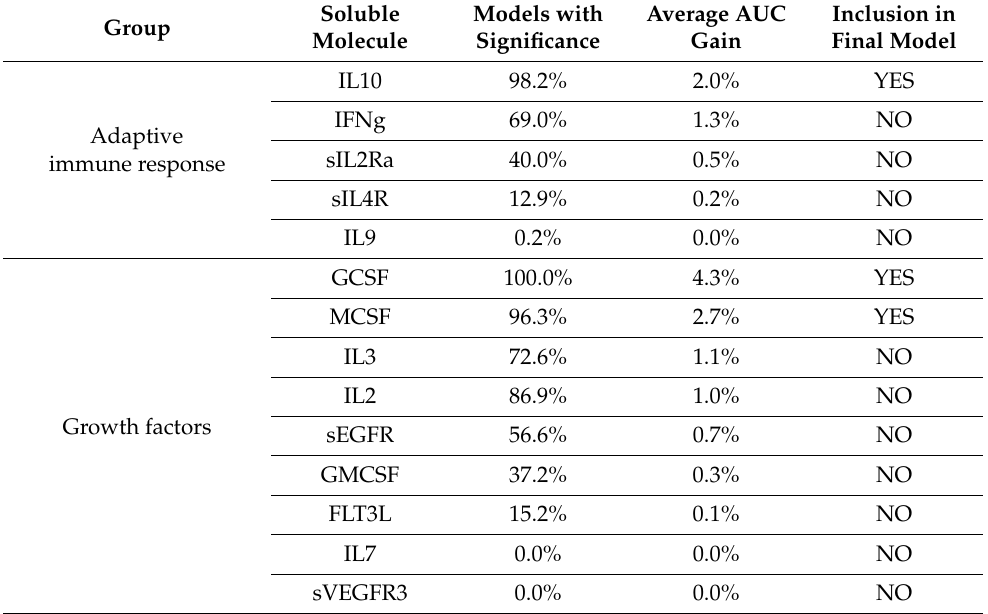
Table 2. Multivariate analysis of the 4495 combinations of 31 regulatory molecules used to predict ICU admission/Exitus in COVID-19 patients. For each molecule, the percentage of models in which the given molecule was significant (at 10%) and the average AUC contribution to ICU/Exitus prognosis calculated according to the clinical score are indicated. Also indicated are the selected molecules for the final prognostic